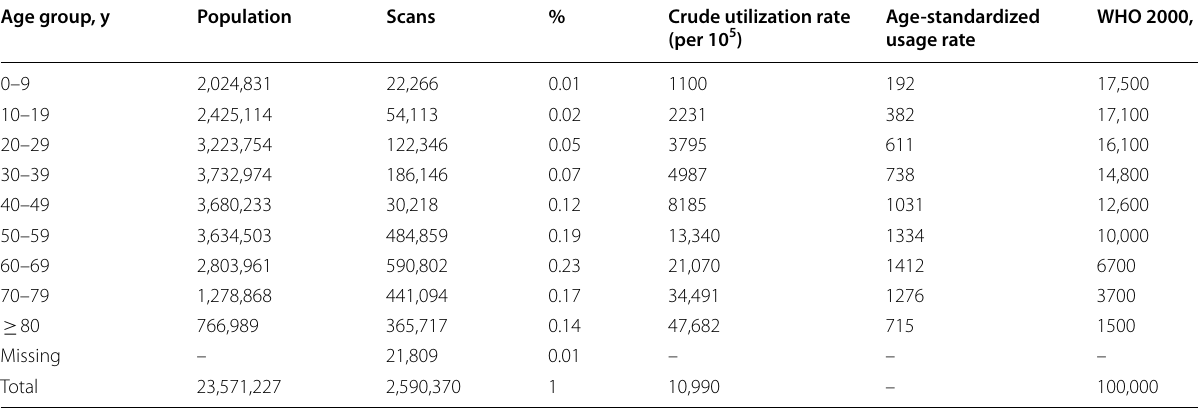
Table 2 Use of CT and MRI by Age Group per 100,000 Population in 2017